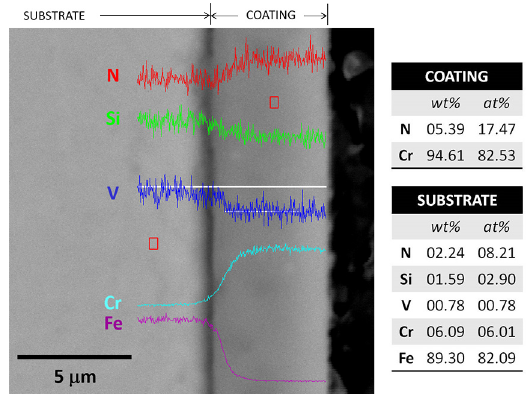
Figure 7. Cross-sectional EDS elemental analysis of the duplex- treated sample.